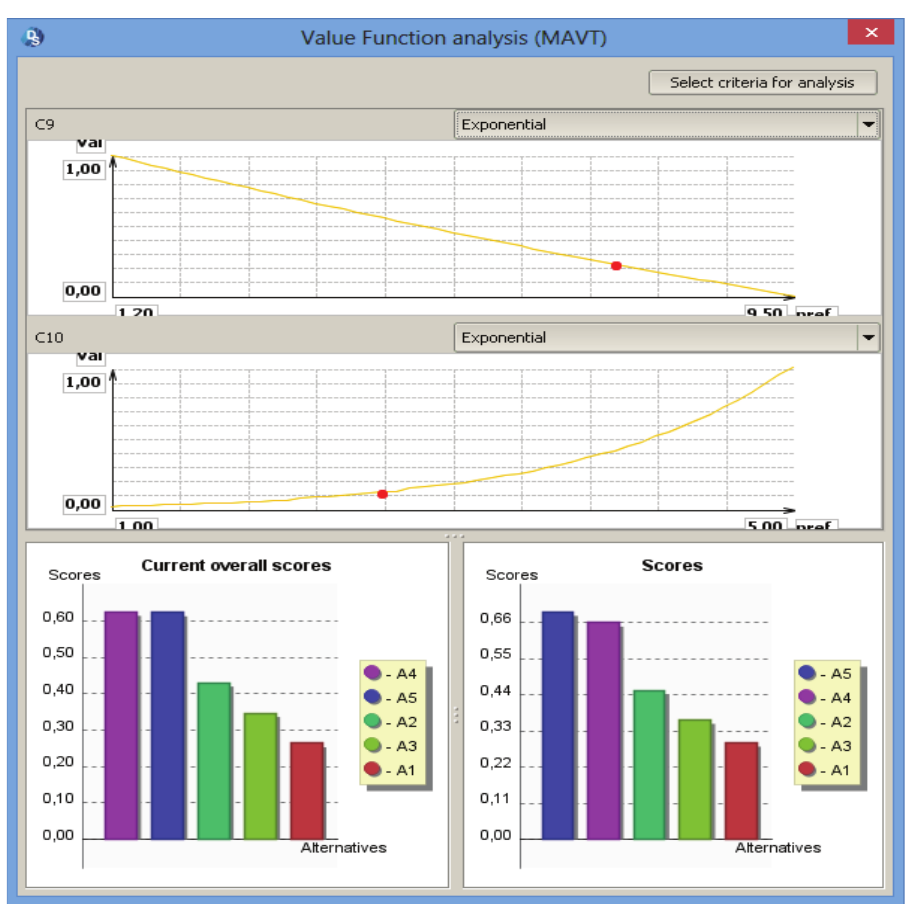
Fig.9. DecernsMCDA : value function sensitivity analysis: right hand picture – Initial ranking, left picture – ranking according to changed partial value function(s).